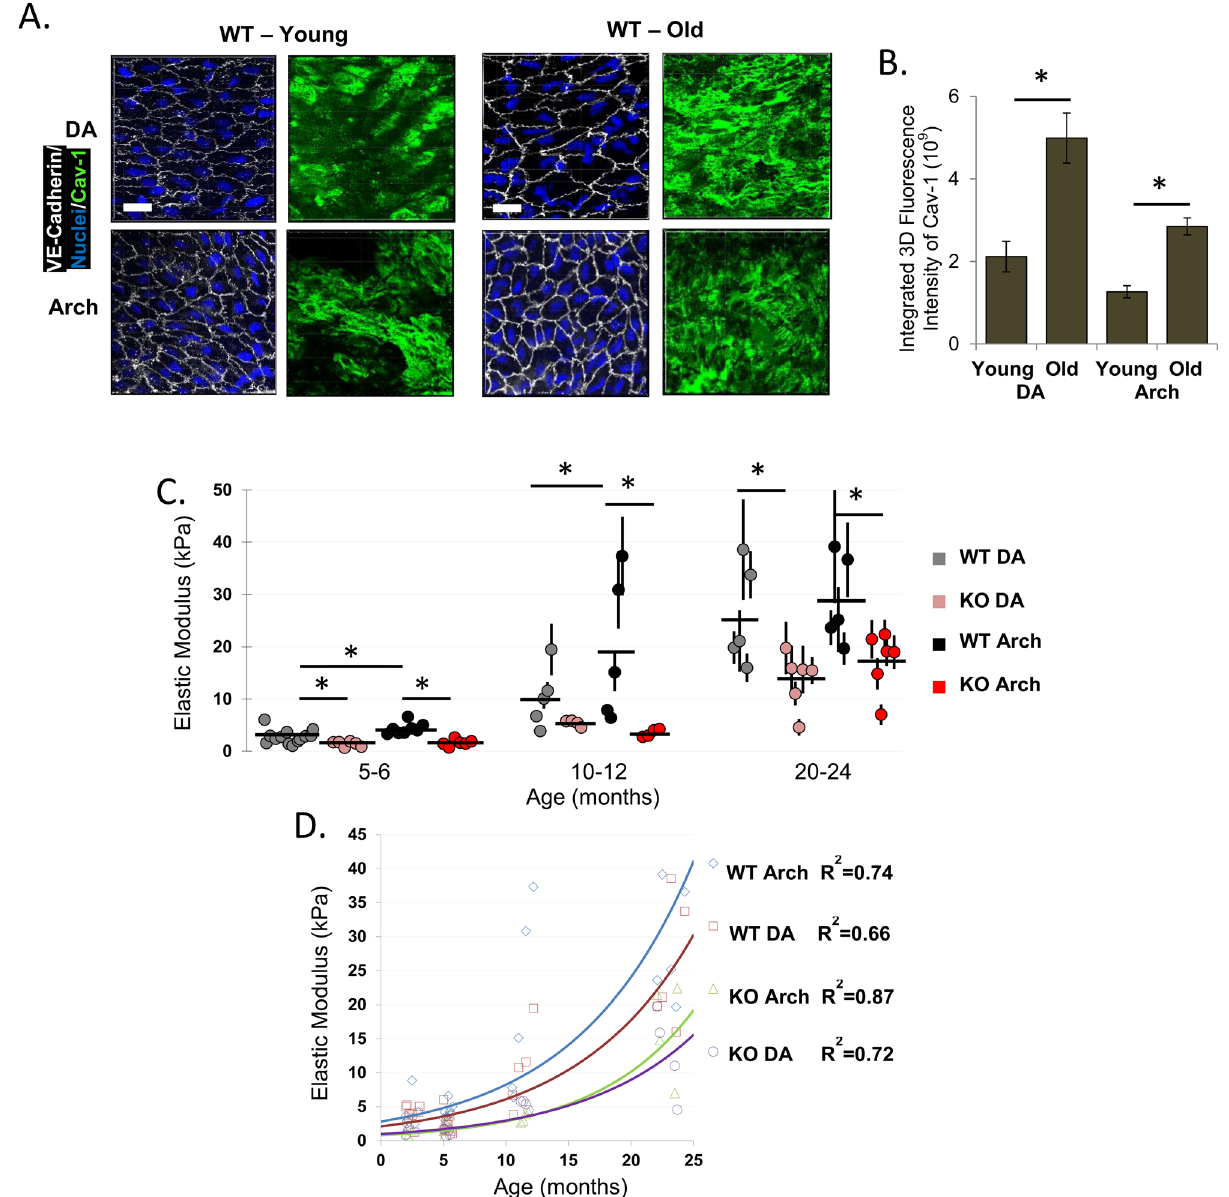
Figure 6. Age-associated increase in mouse aortic endothelial stiffening is mitigated by Cav-1 deletion. ( A ) Representative 3D confocal images (scale bars are 15 µm) of Cav-1 expression in the descending aorta and aortic arch in young (3–4 month old) and older (18–20 month old) WT mice (n = 3–4 mice per condition per age, 2–4 3D images per mouse) and ( B ) its quantification. ( C ) Summary of aortic elastic modulus values for WT and Cav-1 KO mice at each age. ( D ) Exponential curves representing mouse age versus elastic modulus. *P < 0.05 using